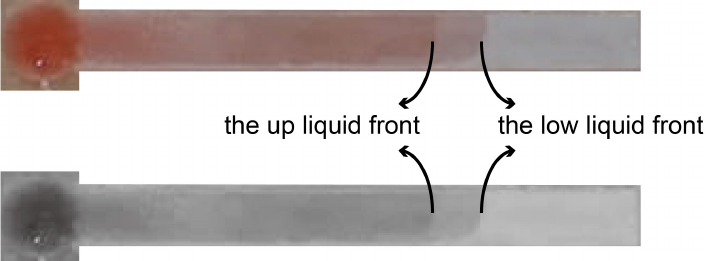
Figure A4. A synthetic paper test strip with liquid penetrating inside. A colorful picture in the top, and a gray picture (processed by ImageJ) in the